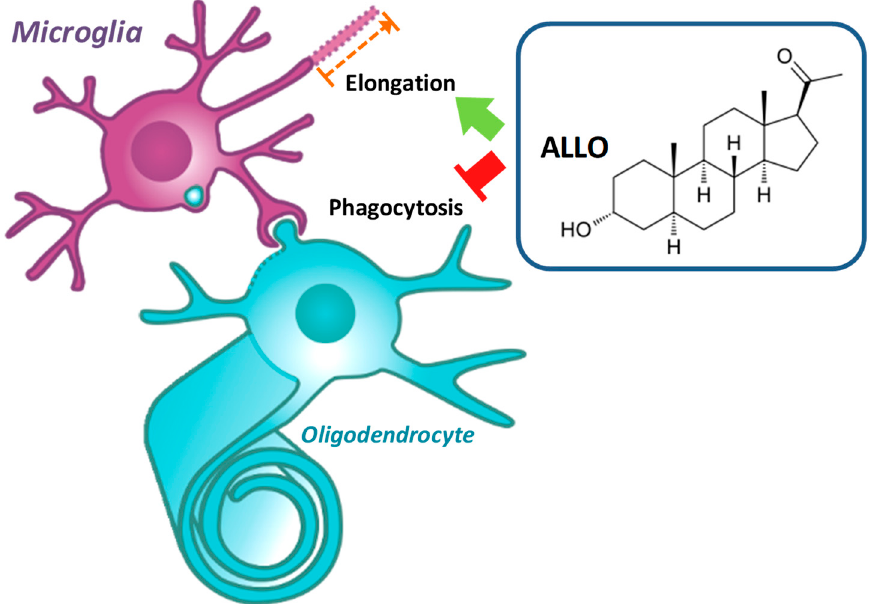
Figure 9. Graphical abstract demonstrates that the natural neurosteroid allopregnanolone (ALLO) inhibits oligodendrocyte phagocytosis by microglia. ALLO modifies also microglial morphology by increasing the length of cell processes. increasing the length of cell